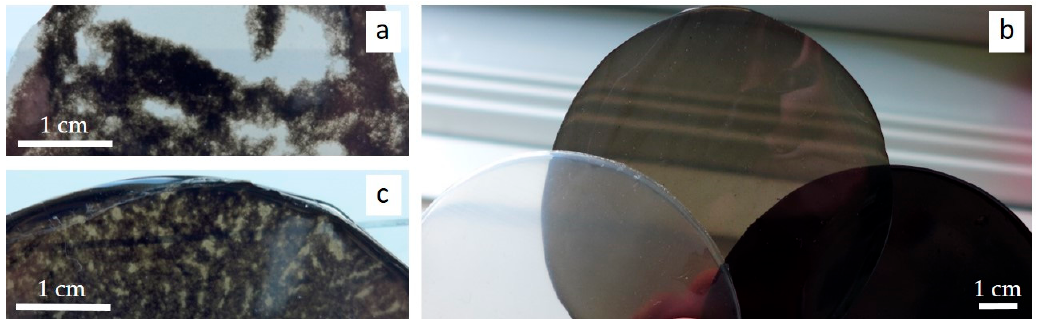
Figure 9. Photographs of BCP/MWCNT composite films: ( a ) 0.1 wt % NC 7000, ( b ) matrix 3G55, 0.1 wt % CNT-PS and 1 wt % CNT-PS (from left to right), ( c ) 0.1 wt % CNT-C18.